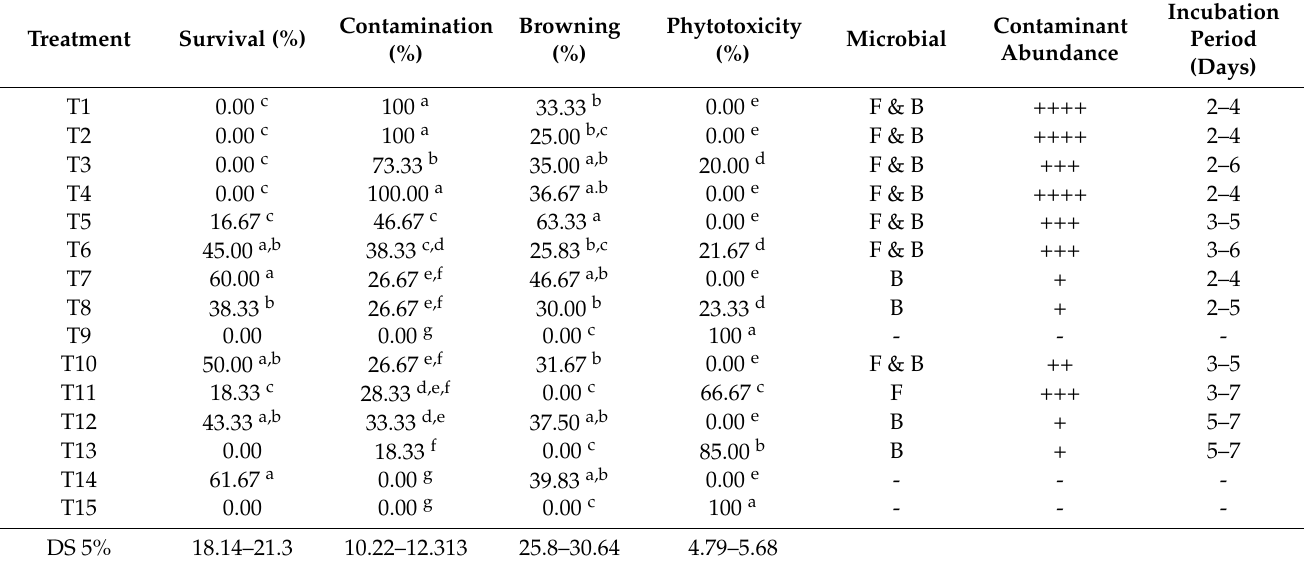
Table 3. Disinfection treatments influence on decontamination of explants from nodal segments in P. quadrangularis .